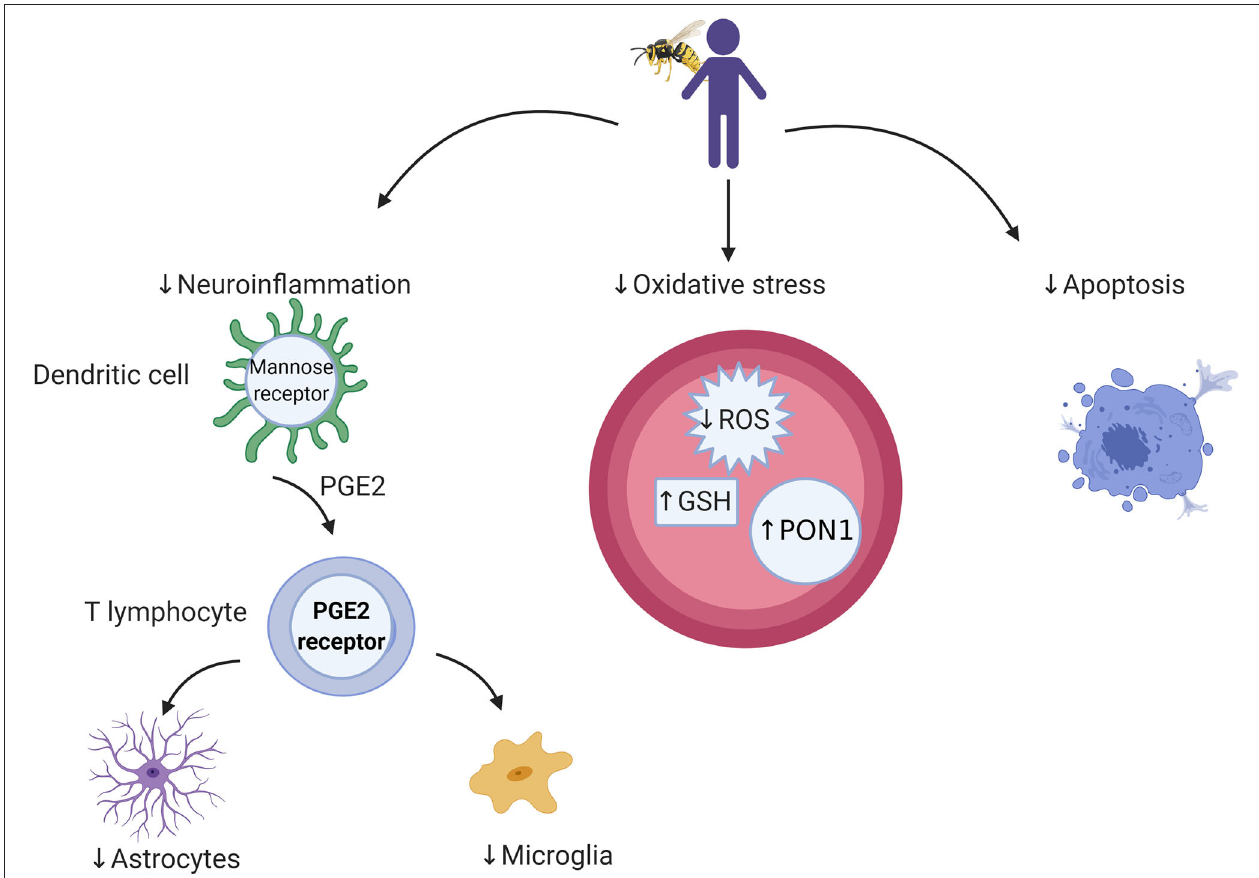
FIGURE 1 | Cellular and microbial targets relevant to bee venom components and targets for future research. Bee venom acts through dendritic cells to stimulate the immune system through which it activates cellular immunity. Its antioxidant activity is associated with a reduction in reactive oxygen species (ROS) and elevation in antioxidant enzymes (e.g., GSH and PON1), which leads to protection against cell